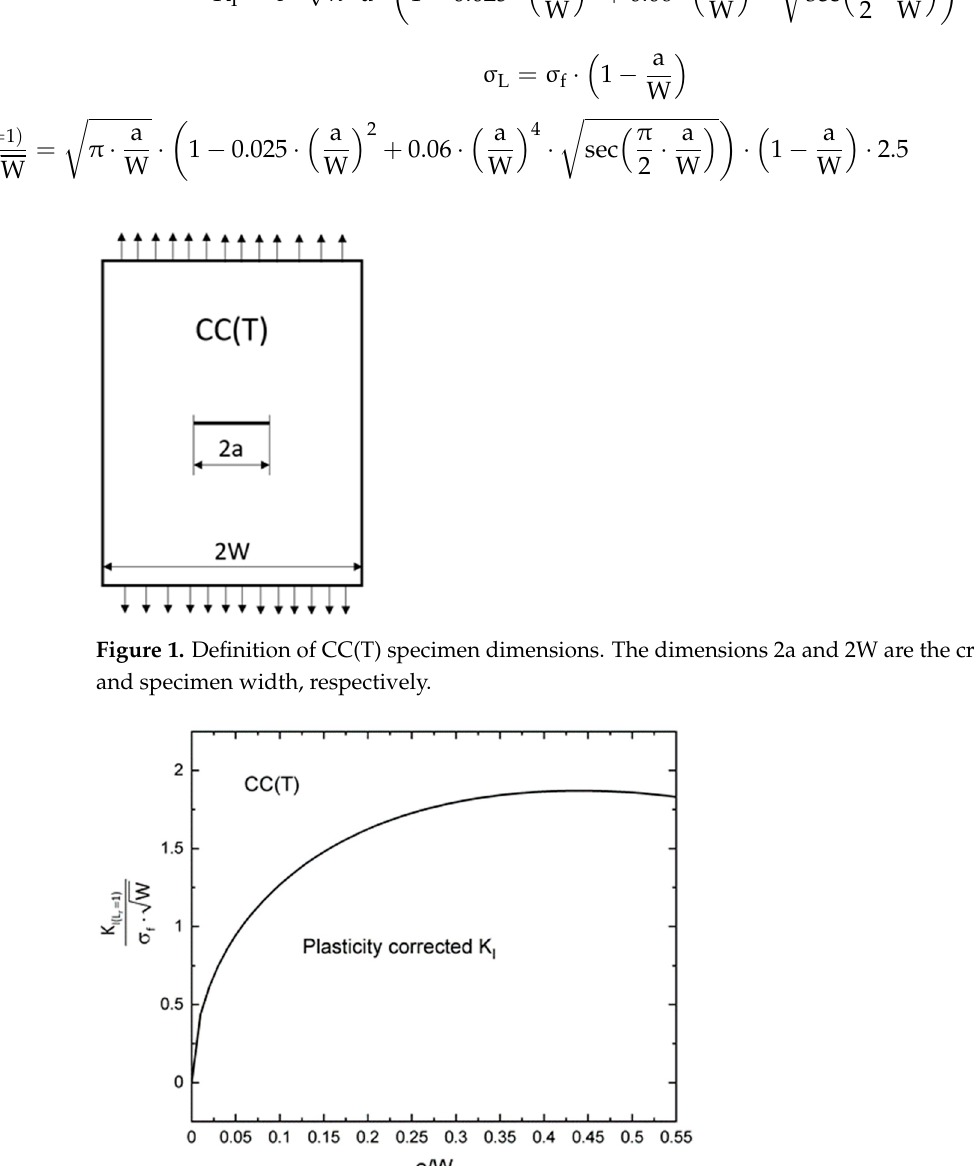
Figure 2. Plasticity-corrected crack driving force at limit load function of relative crack length